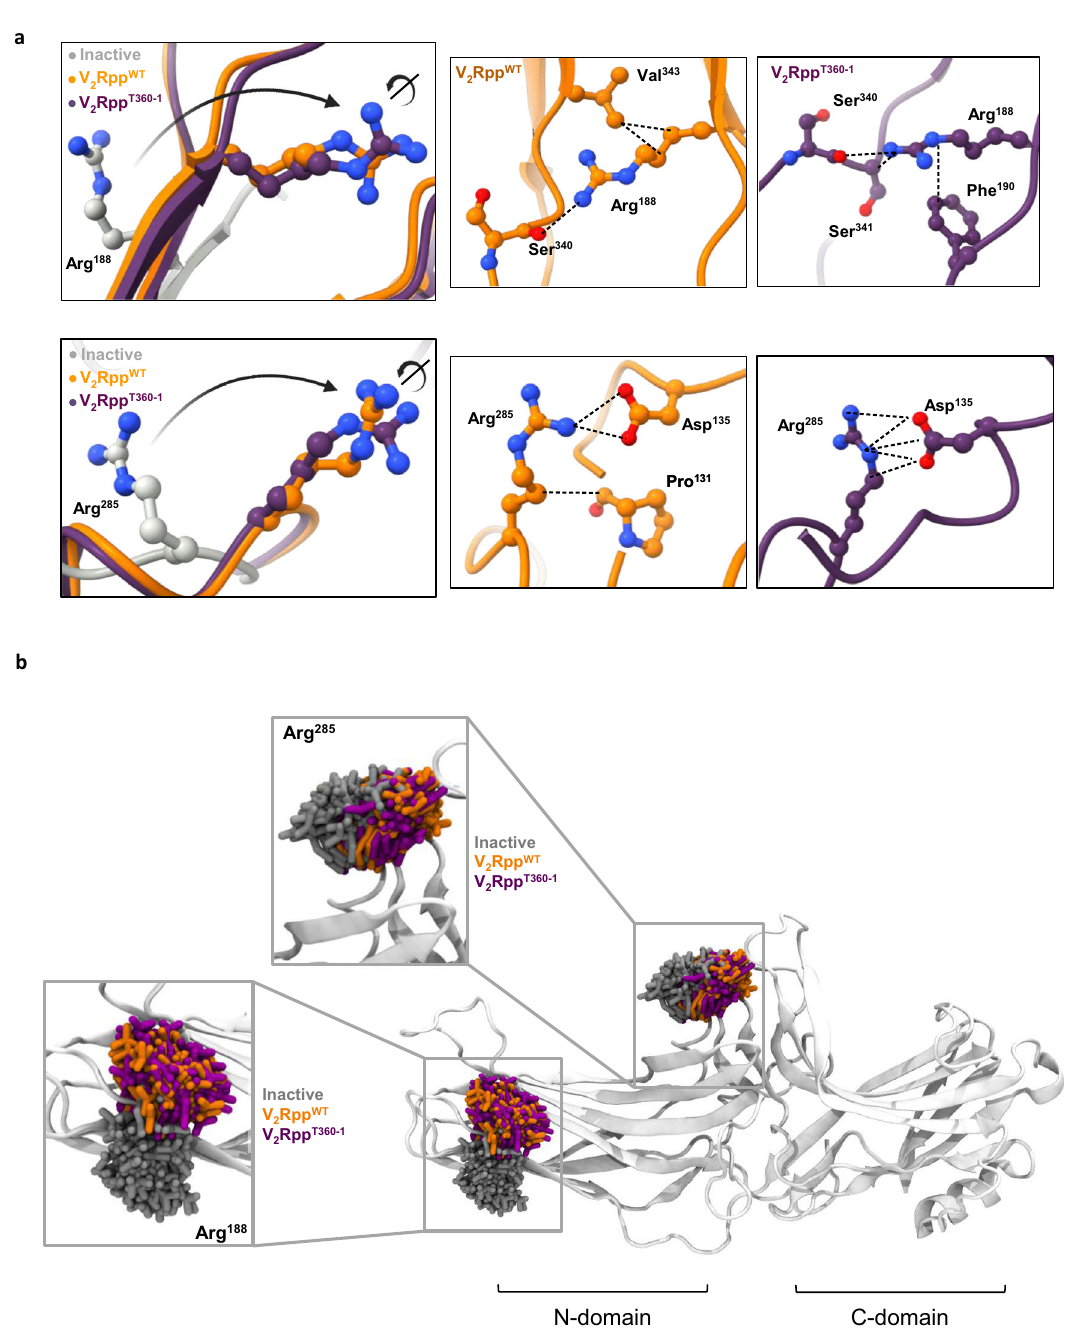
Fig. 3 | Structural insights into binding of phospho-peptides to β arr1. a Structural snapshots comparing the relative orientation and local interaction networksoftrypsincleavagesitesArg 188 andArg 285 inthecrystalstructuresof β arr1 in basal (PDB: 1G4M, grey), V 2 Rpp WT -bound (PDB: 4JQI, orange) and V 2 Rpp T360-1 -